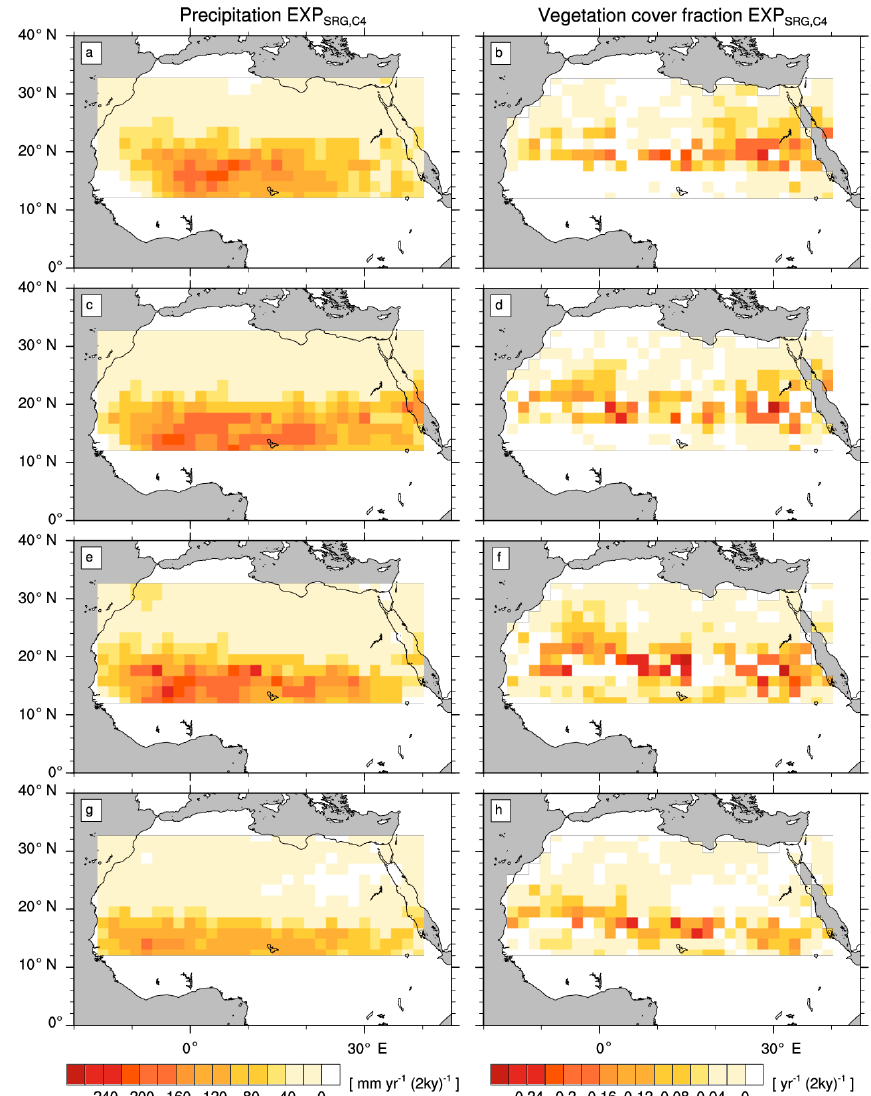
Figure A3. Transition rates from the green Sahara to the desert state for precipitation P (left column) and vegetation cover fraction veg max (right column) of a simulation with C 4 grass and raingreen shrub (EXP SRG , C (100-year averages): 6–8kyr (a, b) , 4–6kyr (c, d) , 2–4kyr (e, f) , and 0–2kyr (g, h)